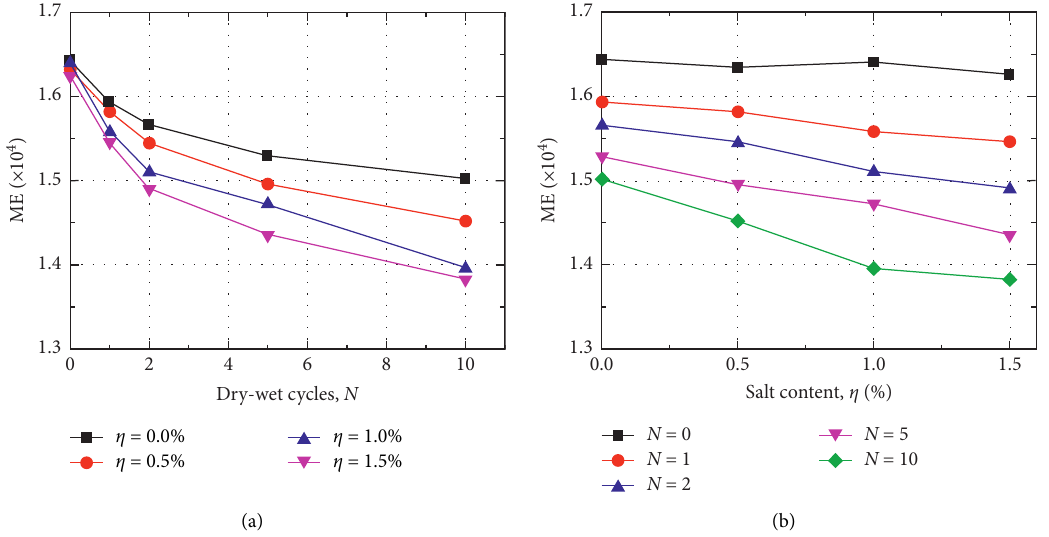
Figure 15: Variations of ME. (a) Effect of dry-wet cycles. (b) Effect of salt content.